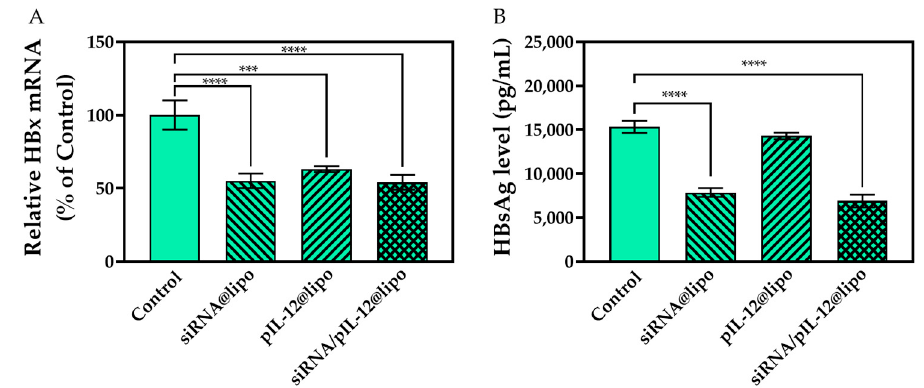
Figure 3. The anti-hepatitis B effects of siRNA- and/or pIL-12-loaded complexes. ( A ) The HBx mRNA level in HepG2.215 cells as determined by qPCR. ( B ) The HBsAg concentration in the culture supernatants of HepG2.215 cells. HepG2.215 cells were treated with siRNA- and/or pIL-12-loaded complexes for 48 h at the siRNA concentration of 60 pmol/mL and/or the pIL-12 concentration of 1 μ g/mL. HepG2.215 cells without treatment were used as a control (*** p < 0.001, **** p < 0.0001; n = 3).